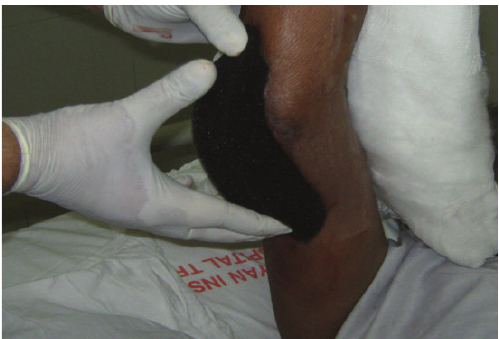
Figure 1: Foam was cut according to wound size.